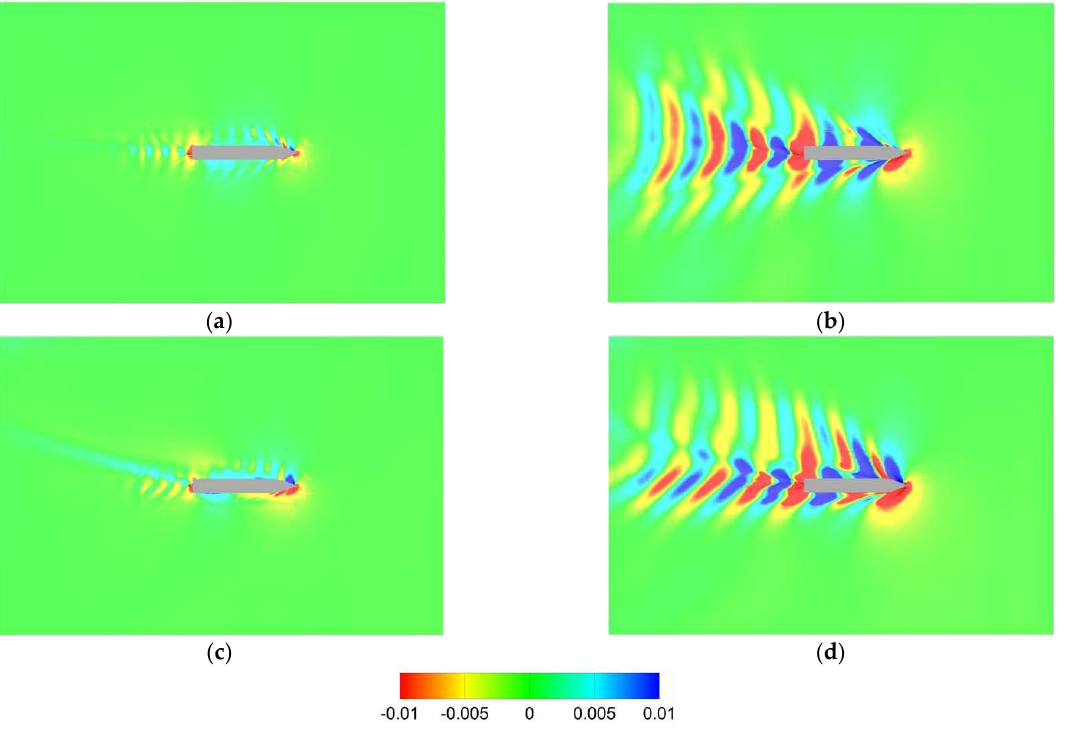
b = −8 deg. Figure 8. Free-surface for static drift simulations of water–air flow. ( a ) Fr = 0.156, β = − 8 deg.